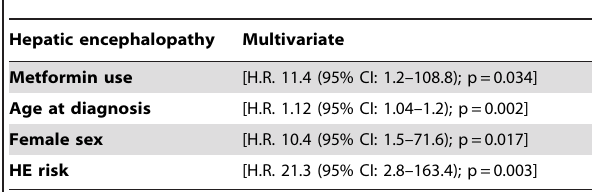
Table 3. Multivariate analysis according to overt